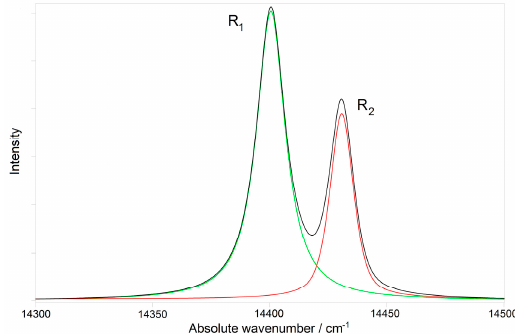
Figure 2. Representative photoemission spectrum of a Biolox ® delta femoral head fitted into the R 1 and R 2 components.